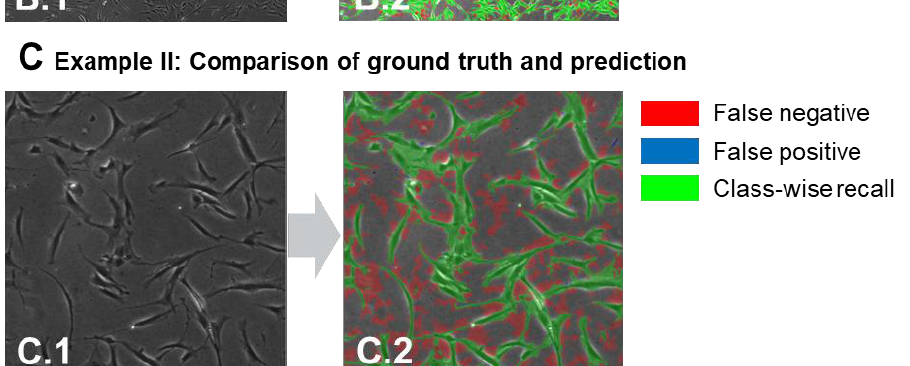
Figure 6. Results of the deep learning approach: ( A ) confusion matrix for pixel classification; ( B ) representative image of the outcome of the deep learning network; ( B.1 ) original image; ( B.2 ) outcome with false positive and false negative classifications and class-wise recall. ( C ) Representative image with high false negative classification; ( C.1 ) original image; ( C.2 ) outcome with false positive and false negative classifications and class-wise recall.